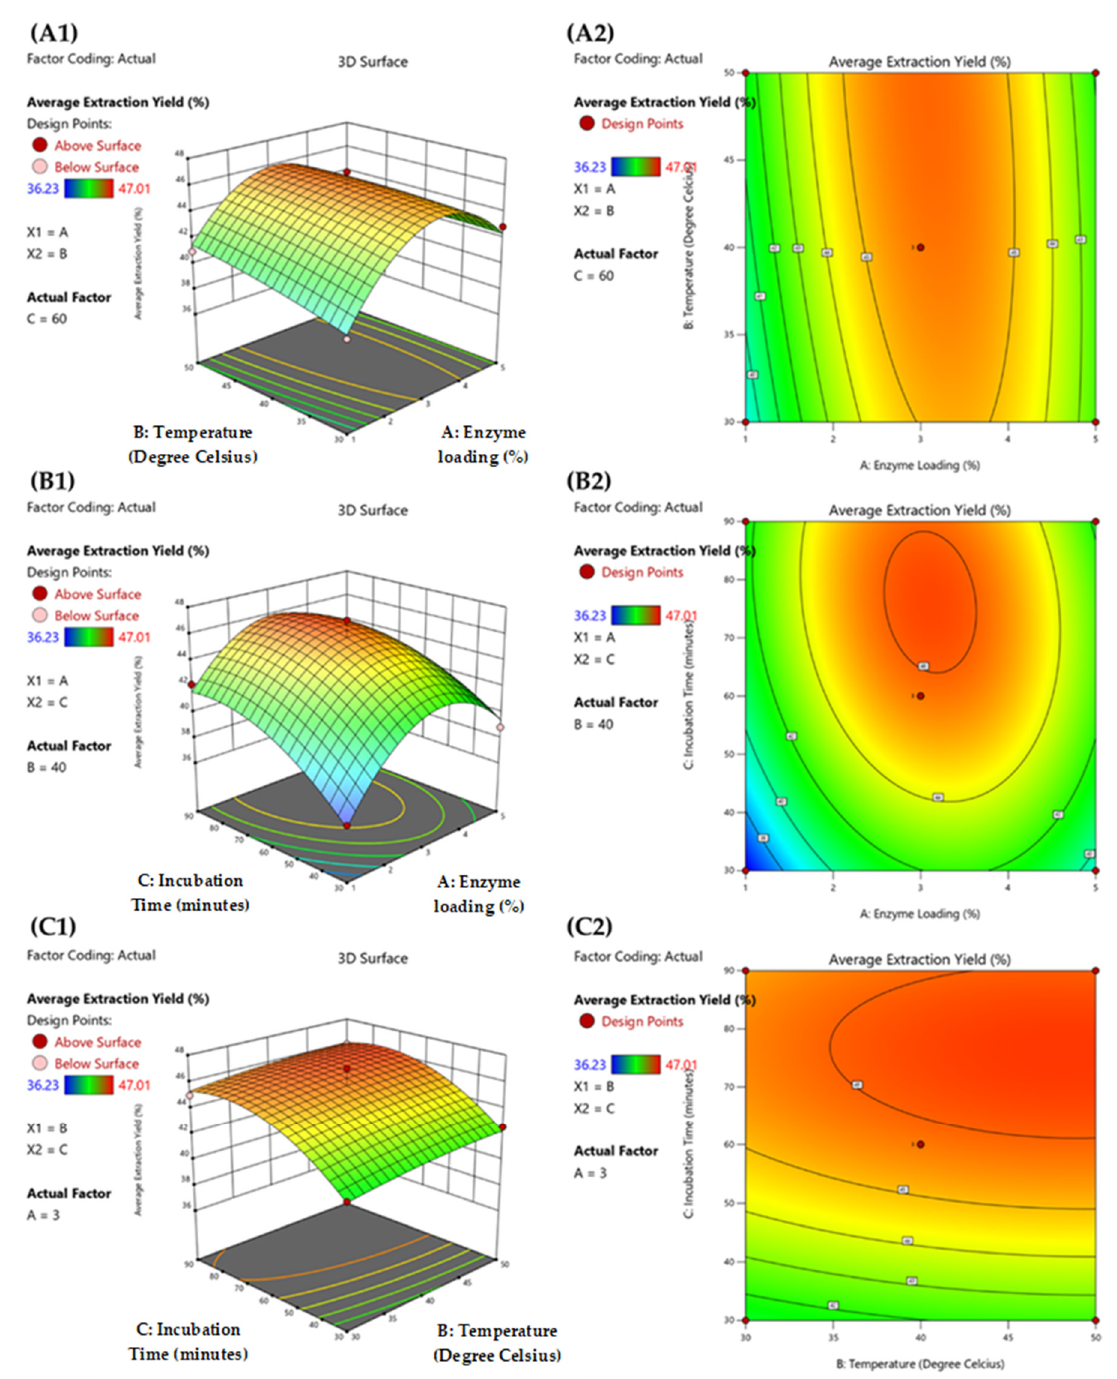
Figure 2. ( A1 , A2 ) Three-dimensional surface plot and contour plot of enzyme loading (%) and incubation temperature ( ◦ C) with 60 min of incubation time, ( B1 , B2 ) enzyme loading (%) and incubation time (h) at a constant incubation temperature (40 ◦ C) and ( C1 , C2 ) incubation temperature ( ◦ C) and incubation time (h) with 3% ( w / w ) enzyme loading.